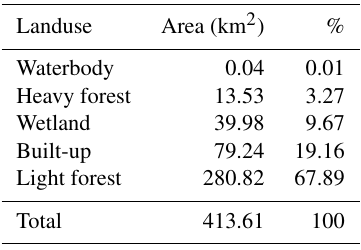
Figure 8. Landuse susceptibility classification. Table 8. Basin areas susceptible to